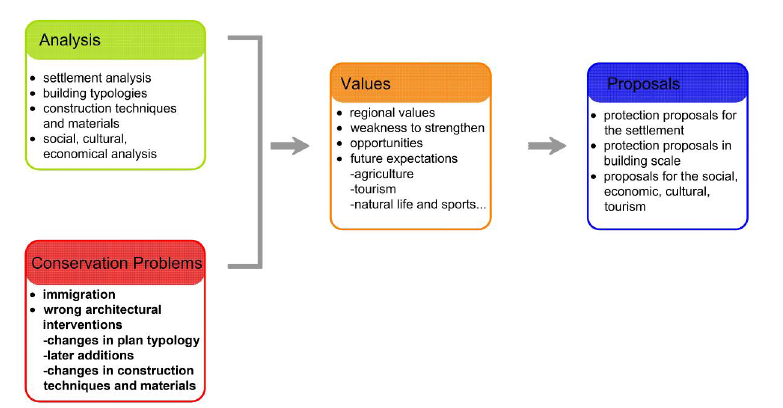
Figure 3 Settlement input and output analyses diagram (illustration: